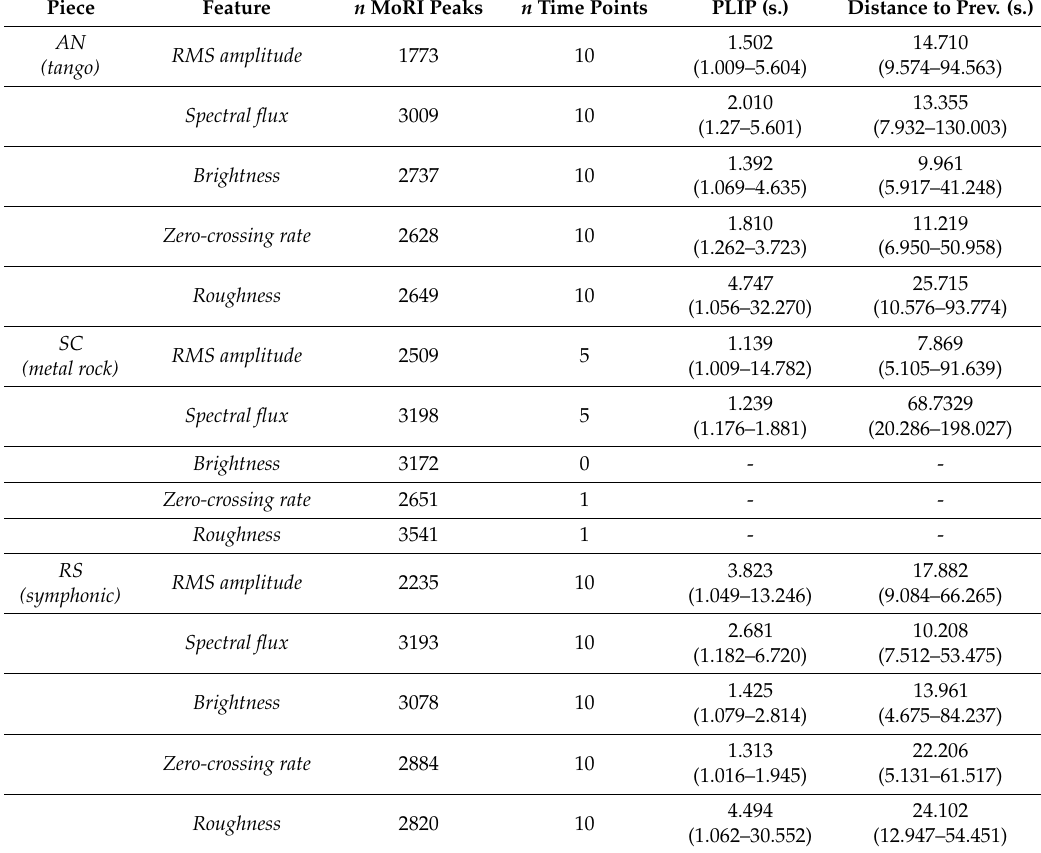
Table 1. Automatically extracted time points. The number of peaks in the music information retrieval (MIR) feature increases, n magnitude of rapid increase (MoRI) peaks, corresponds to the MIR feature increase peaks among the 30% highest of the MoRI values. The assumed best time points, n time points, are the number of automatically extracted time points. For the assumed best time points with feature increase evoking brain responses the median PLIP in seconds and distance to previous time points in seconds are shown with ranges in